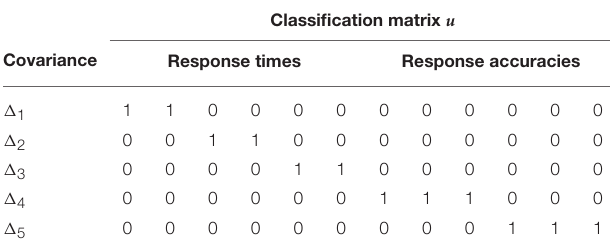
TABLE 4 | The additive covariance structure of the differential blocked structures of cross-covariances across factors model is an extension of the variable speed-accuracy trade-off model with independent testlet structures for separate data types.